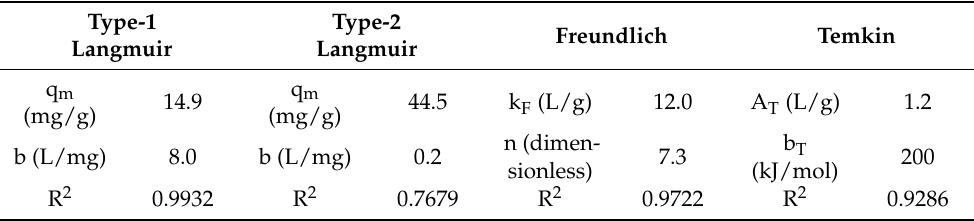
Table 2. Calculated parameters and correlation coefficients for the equilibrium isotherms.